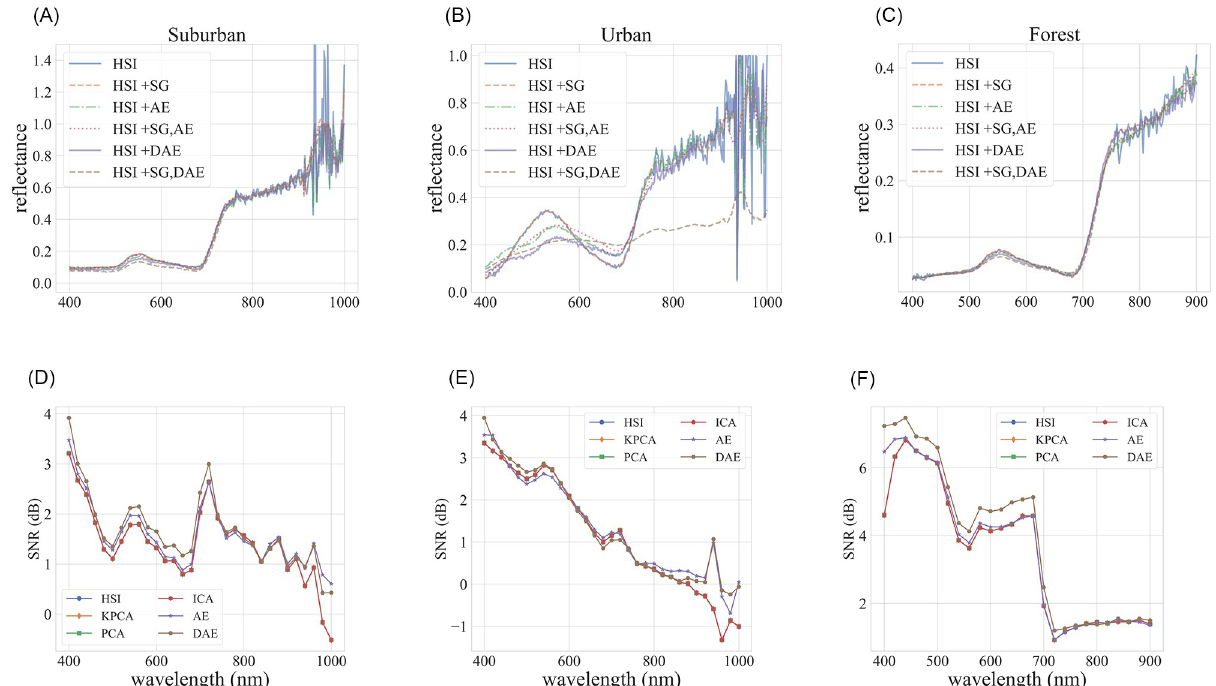
Fig 2. First row : Spectral reconstructions for a randomly selected pixel in the three images. HSI denotes the original spectral signal. HSI+SG refers to the denoised spectral signal. HSI+AE and HSI+DAE denote reconstructed spectral signals using autoencoder and denoising autoencoder, respectively. HSI+SG+AE and HSI+SG+DAE denote reconstructed spectral signal using transformed encodings (0% Compression rates) from denoised signals (HSI +SG). Second row : Signal-to-Noise Ratio of the reconstructed spectra (PCA, KPCA, ICA, AE, DAE) compared to the original pixel (HSI).